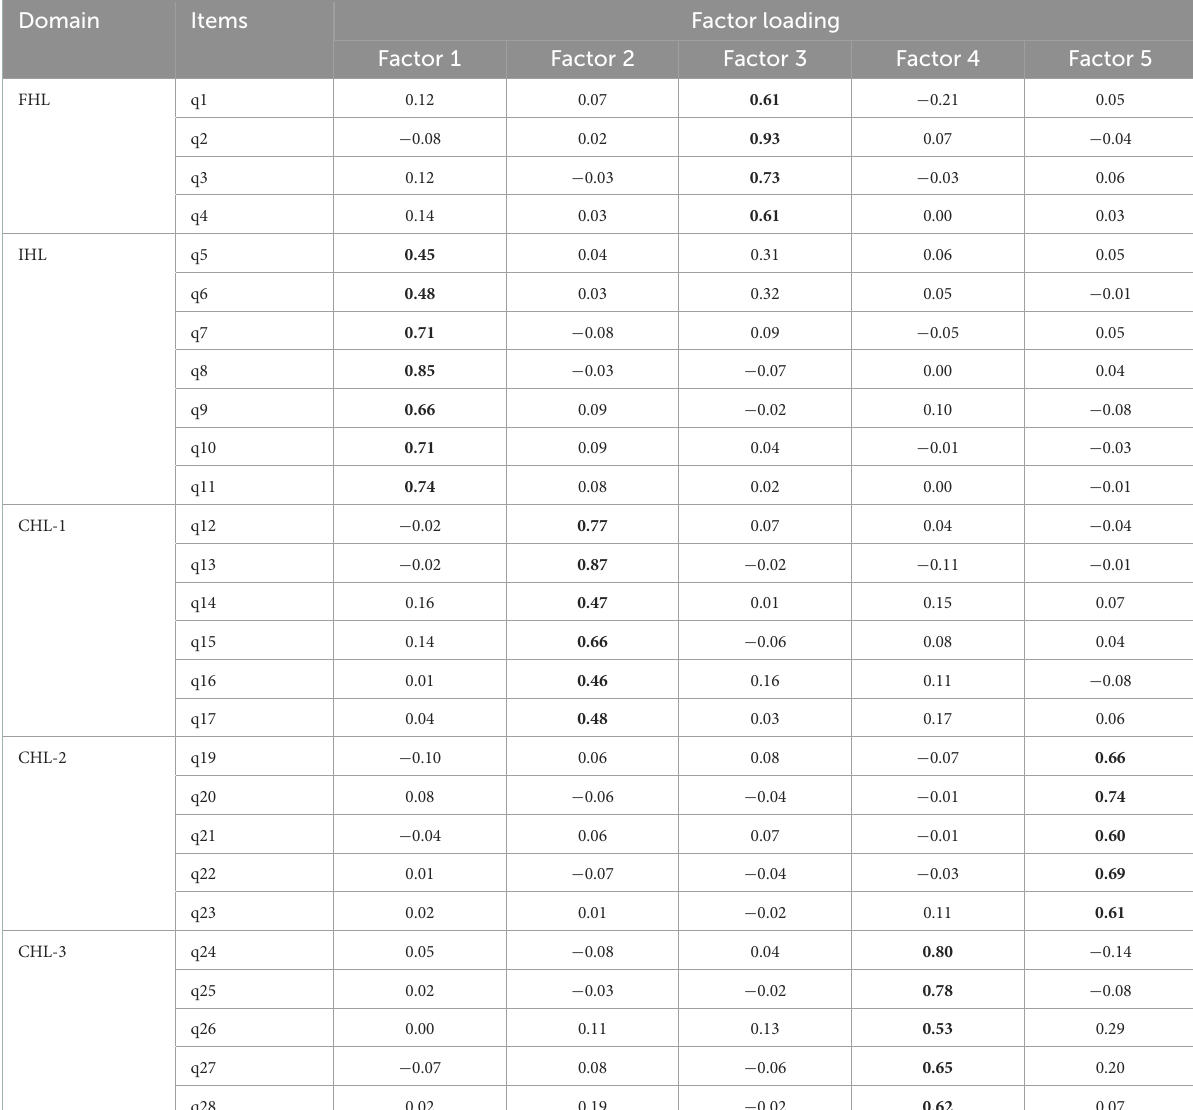
TABLE 5 Item scores and factor loadings of HLS-HK (27